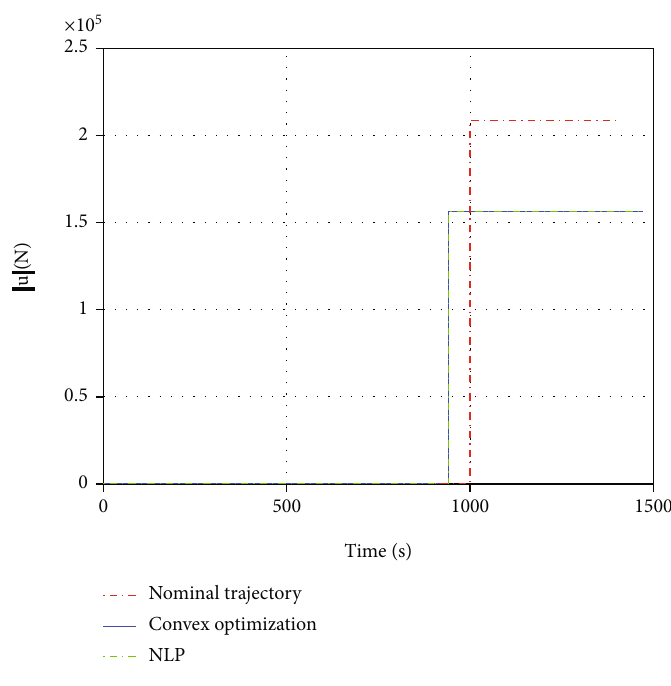
Figure 9: Curve of thrust magnitude. Table 3: Comparison of simulation